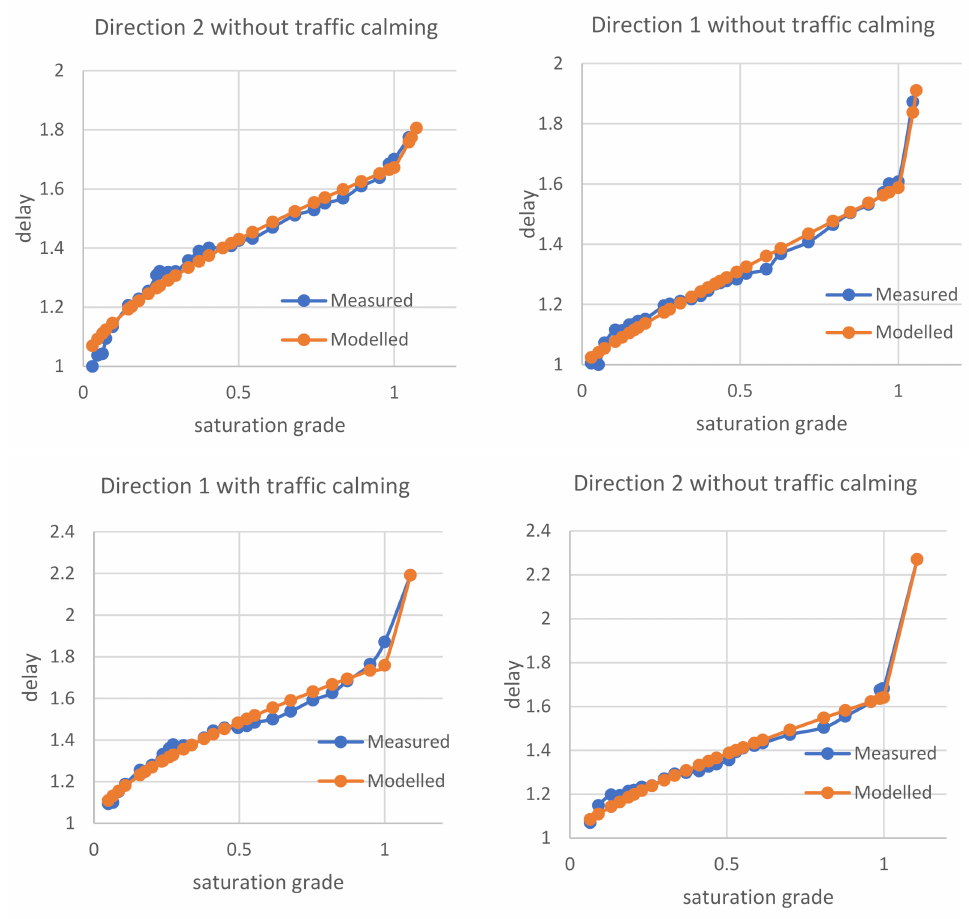
Figure 14. Fitting of the volume–delay functions, source: